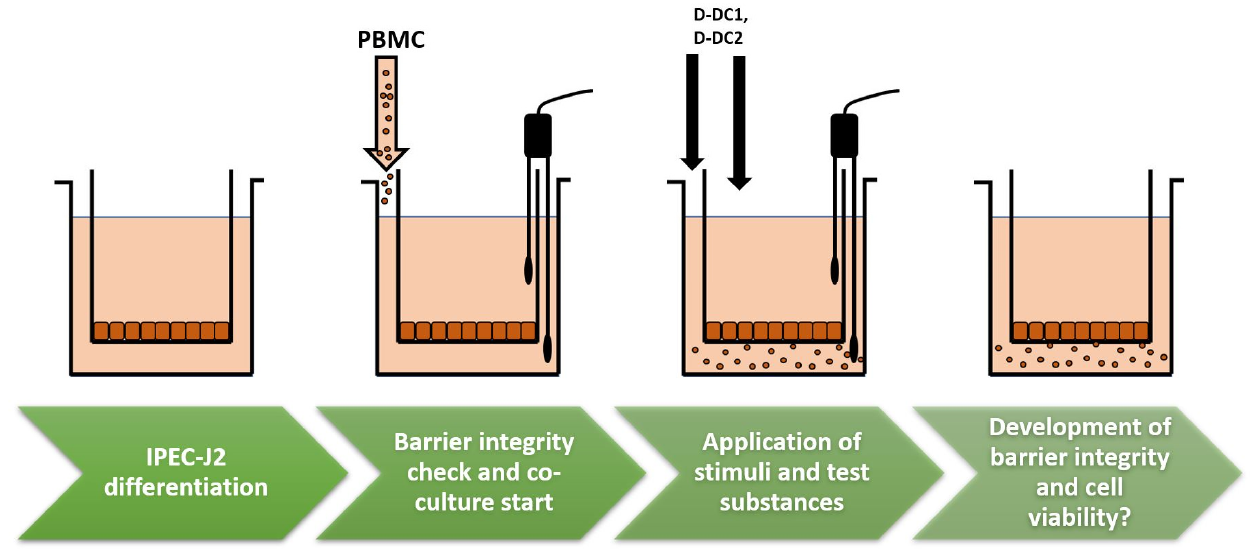
Figure 4. Schematic drawing of the Indirect co-culture